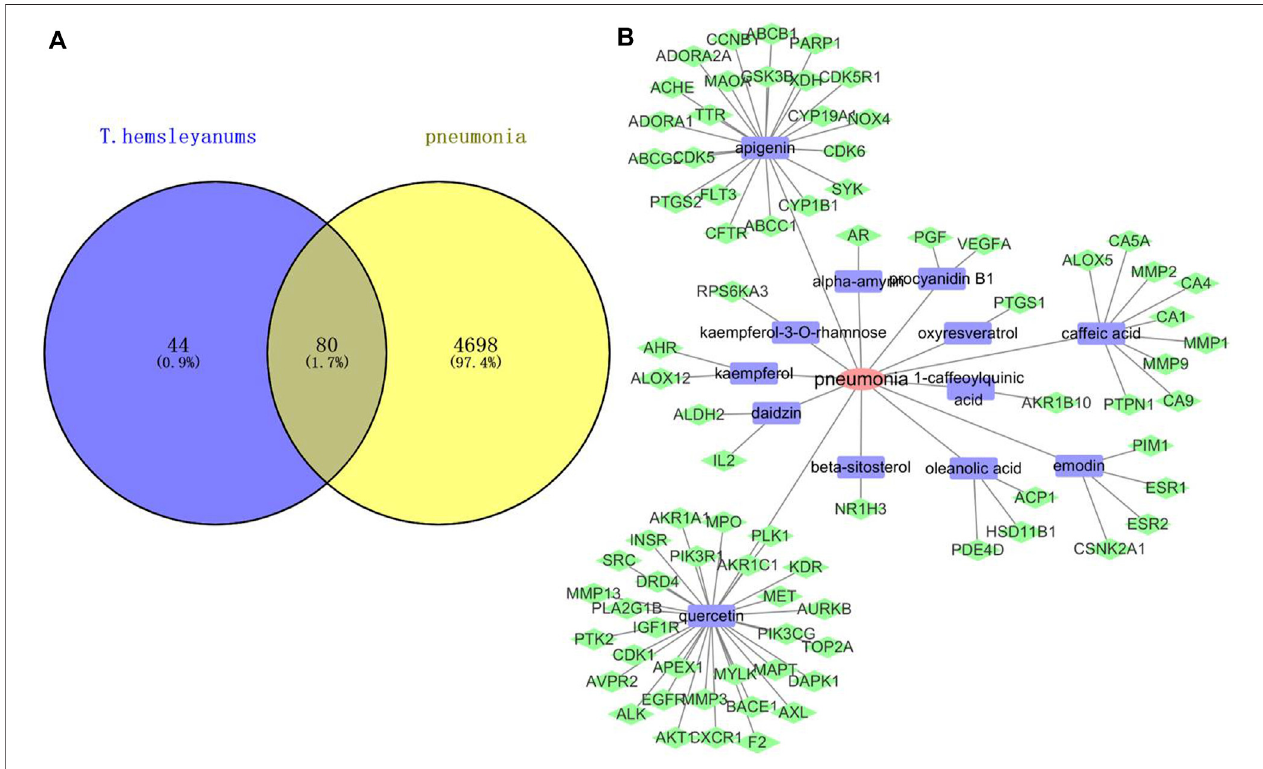
FIGURE 1 | Network analysis of disease and compound targets. (A) Venn diagram of T. hemsleyanum targets and pneumonia targets; (B) the disease – compound – target network of T. hemsleyanum leaf. Green represented drug – disease intersection proteins, red represented pneumonia, and blue represented active